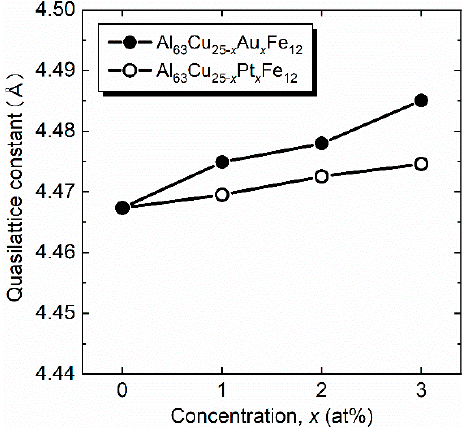
Figure 1. X-ray diffraction patterns of ( a ) Al 63 Cu 25 − x (Au,Pt) x Fe 12 ( x = 0, 1, 2, 3), together with peak indices and calculated peak positions of Al 2 Au, and ( b ) Al 63 Cu 25 − x Pt x Fe 12 ( x = 0, 1, 2, 3). Arrows indi- cate peaks of excess phase of Al 2 Au.